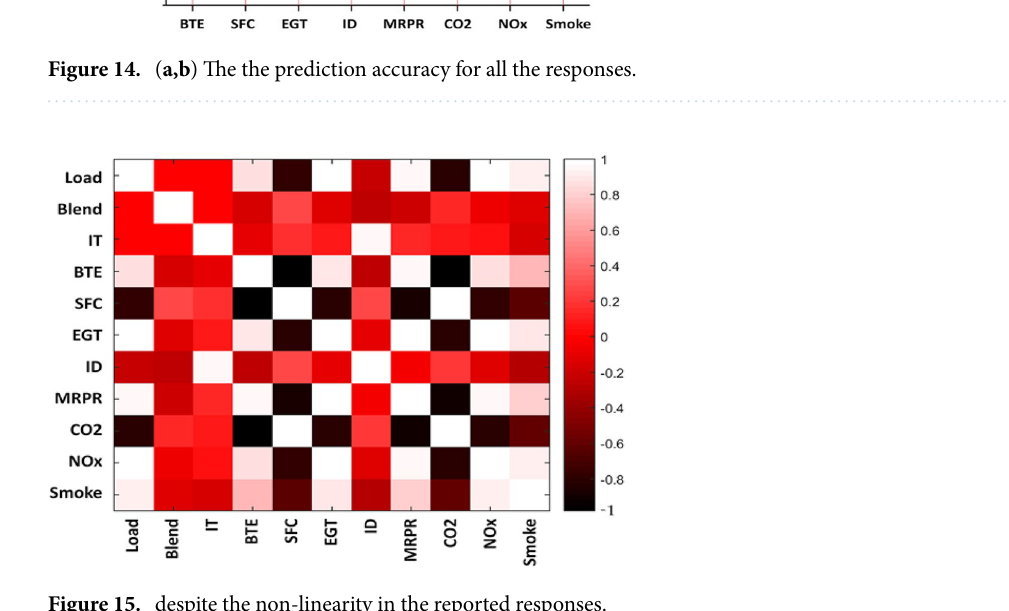
CO 2 emission. Figure 12 depicts the variance of CO2 emissions with load at various FITs (a-e). For all tested fuels, CO2 emissions increased as FIT increased and reduced as engine load increased. The CO2 emissions from diesel gasoline with a delayed FIT were lower. CO 2 emissions for LA100 were 823.2, 833.84, 845.6, 905.1, and 943.2 g/kWh at 19°, 21°, 23°, 25°, and 27° bTDC, respectively, compared to diesel fuel emissions of 779.4, 798.2, 807.23, 816.2, and 824.23 g/kWh at 19°, 21°, 23°, 25°, and 27° bTDC. This could be owing to a longer ignition delay, which allows for better mixing of the air–fuel mixture. This could create a fuel-rich zone, resulting in improved fuel combustion and increased CO2 emissions.